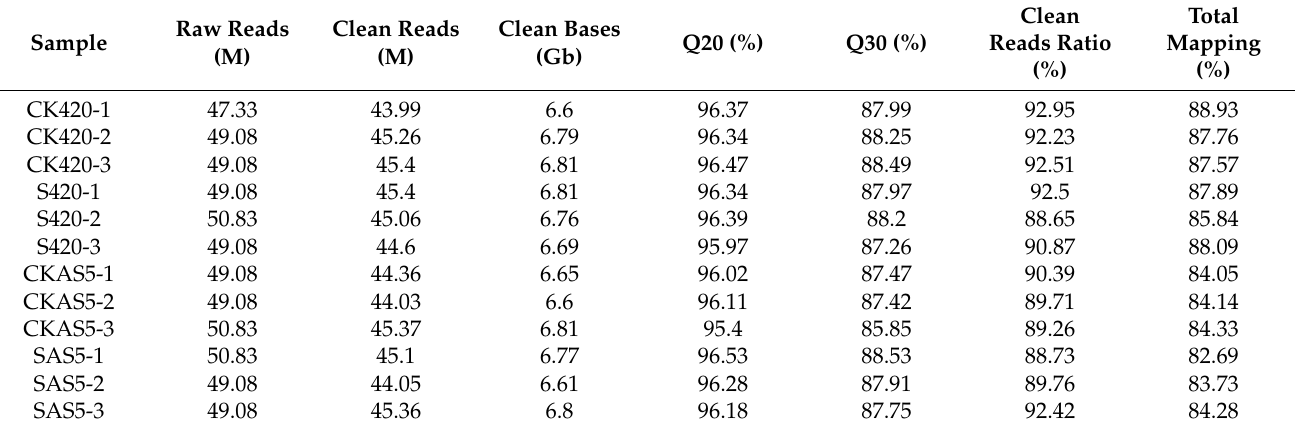
Table 3. Summary of mapping reads and